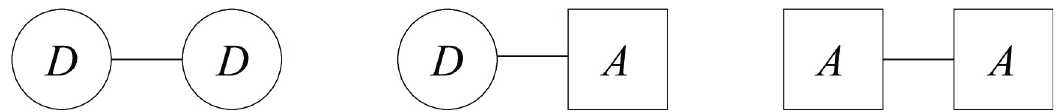
Fig 2. The structure of the three possible conflicts between two groups ( D and A are defense and attack groups, respectively).